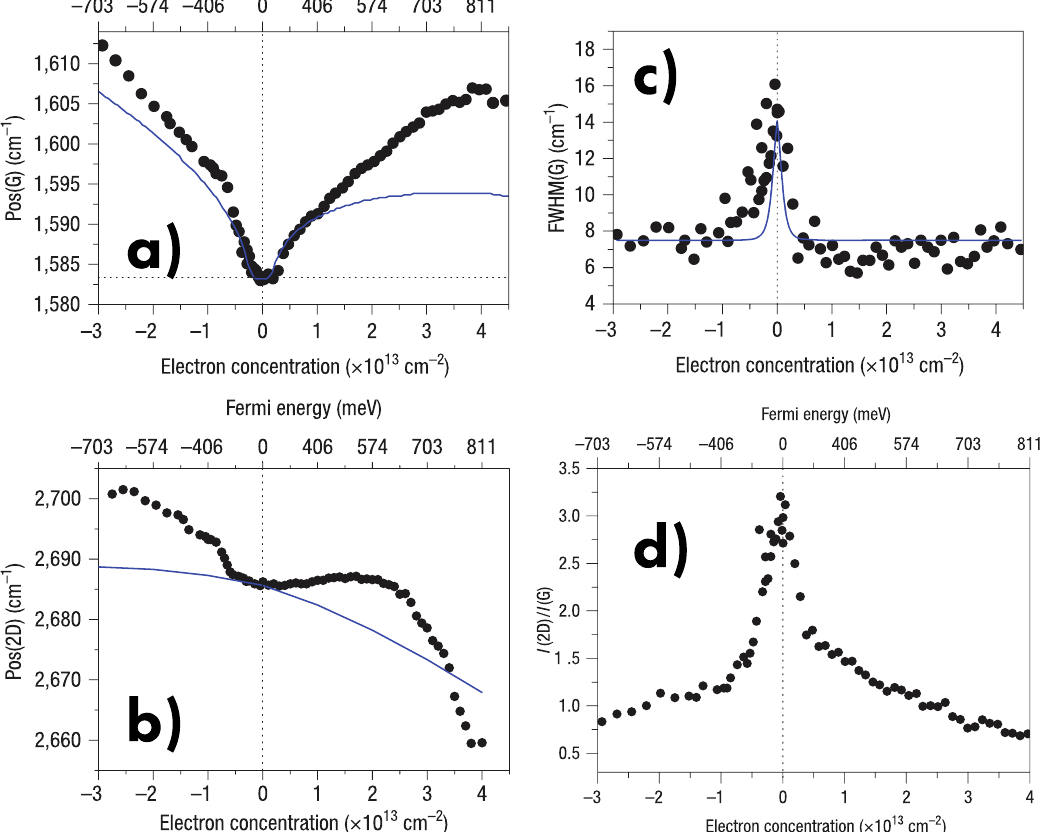
Figure 26. Modification of peak frequency of ( a ) G band and ( b ) 2D band, ( c ) G bandwidth, and ( d ) ratio between G and 2D integrated intensity for graphene doped by gate voltage application. Reprinted with permission from Ref. [102]. Copyright (2008) Springer